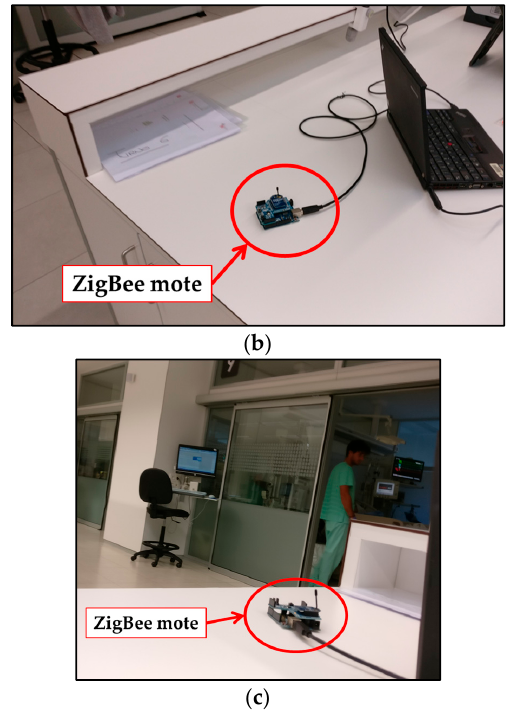
Figure 10. ( a ) Schematic view of the scenario with the position of the transmitter (red dot) and the measurement points (green dots); and ( b , c ) the detail of how the XBee-Pro mote has been deployed. Once the measurements have been taken, the 3D Ray Launching simulation has been launched in order to obtain the estimated RF power distribution for the whole volume of the scenario. Table 3 shows the main parameters used for the 3D Ray Launching simulations, which have been selected as close as possible to the real parameters of the XBee-Pro module and the antenna of the spectrum analyzer. Figure 11 shows a bi-dimensional plane of the RF power distribution at height 1.5 m. Generally, in indoor complex environments, the most important radio propagation phenomenon is the multipath propagation. Due to the complex morphology of this scenario, the multipath propagation has a great impact on the radio propagation. This phenomenon causes rapid RF power variations along the distance. To see this effect, in Figure 12 three linear paths vs. received power level graphs are shown. These curves correspond to the three white dashed lines in Figure 11. The typical rapid RF power variations due to the multipath propagation can be clearly noticed in Figure 12.